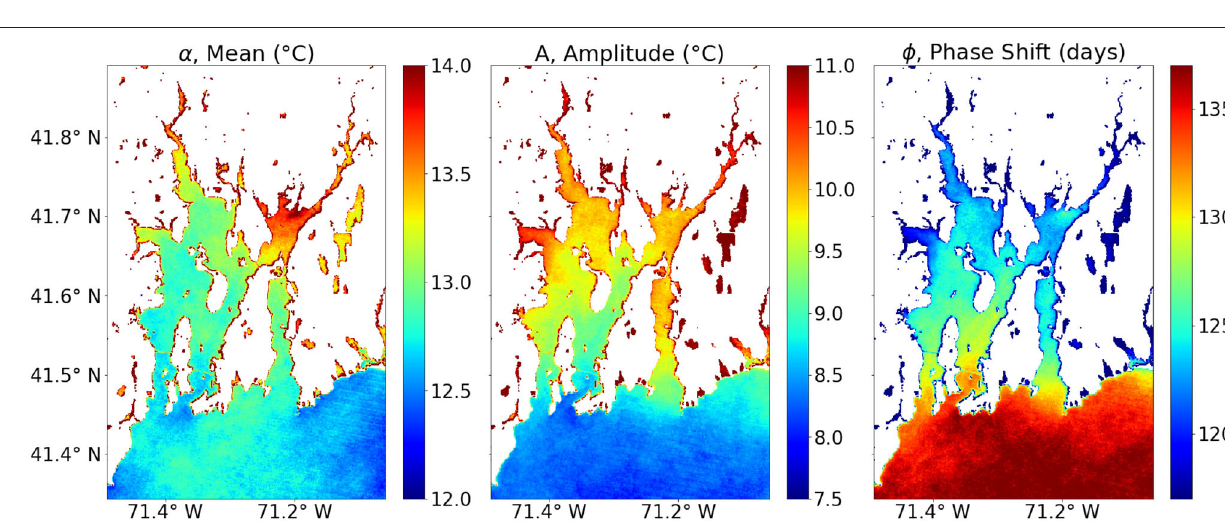
FIGURE 5 | Maps of climatology coefficients as described by Equation (1.2) calculated over 1984–2010. The climatology from the entire observation period (1984–2021) was used to seasonally detrend the data. Here the impact of the BPPS effluent is visible as an increased α term and decreased φ term near Brayton Point, representing greater mean temperature by 1 ◦ C or more and a delayed seasonal cycle by up to 4